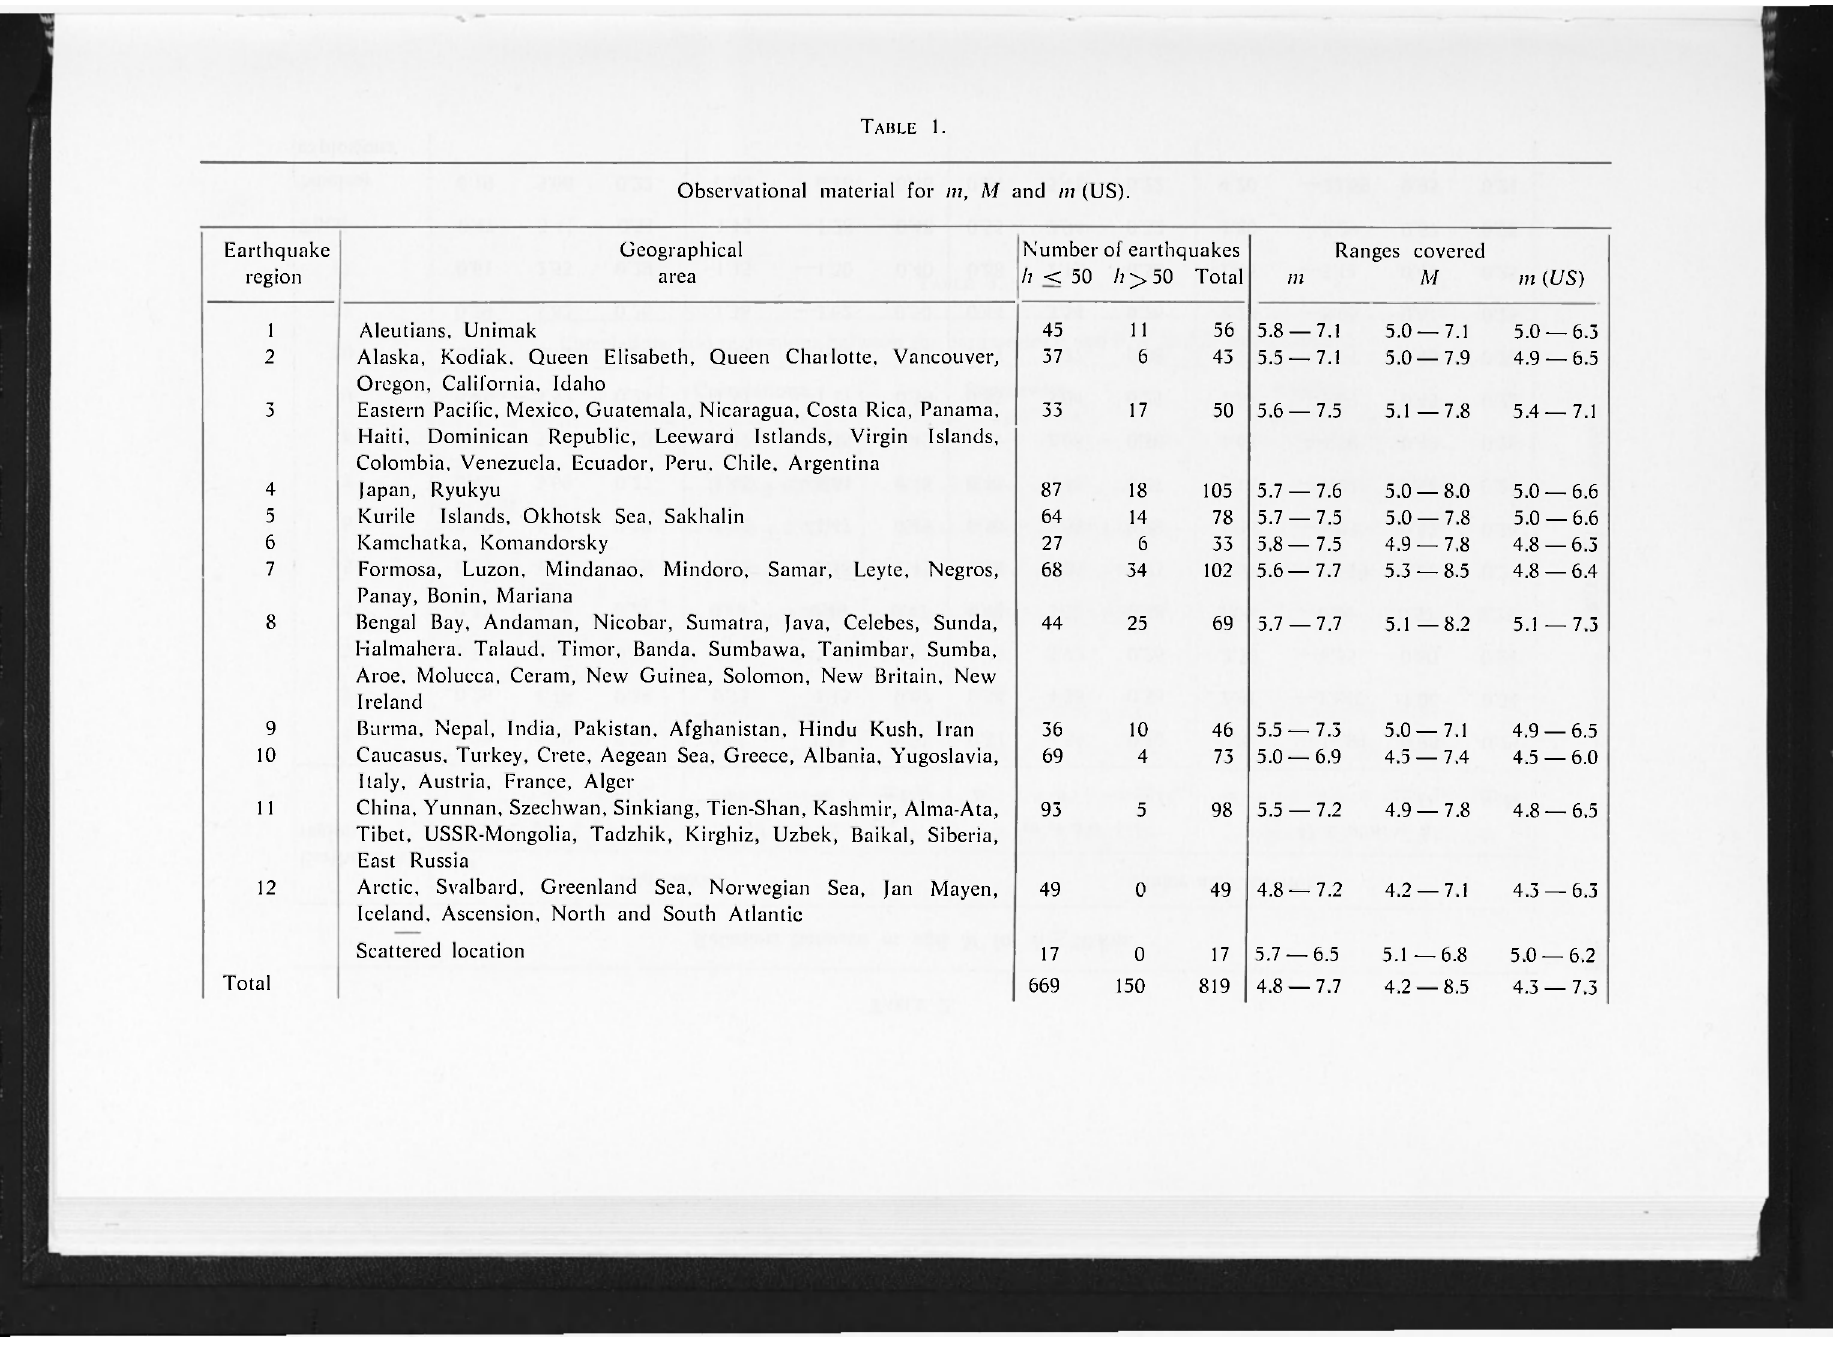
Observational material for m, M and m